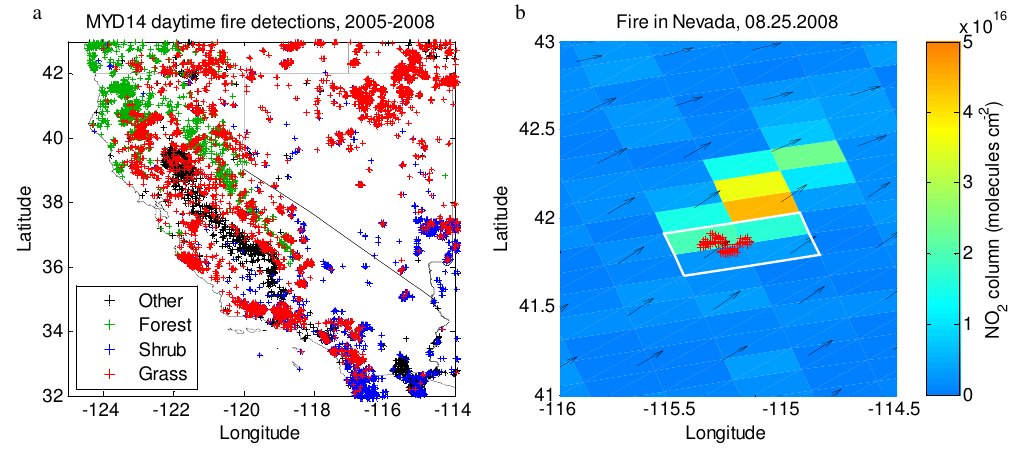
Fig. 1. (a) MODIS fire detections (totaling ∼ 2 . 8 × 10 4 1km pixels) from the daytime EOS-Aqua overpass over California and Nevada, for 2005–2008, colored by land type. (b) OMI tropospheric NO 2 column densities (molecules cm − 2 ), overlayed with MODIS fire detections (red) and NARR wind vectors (black arrows) for a fire detected in Nevada on 25 August 2008; OMI pixels analyzed for this fire are outlined in white. Average wind speed shown is 8.23ms − 1